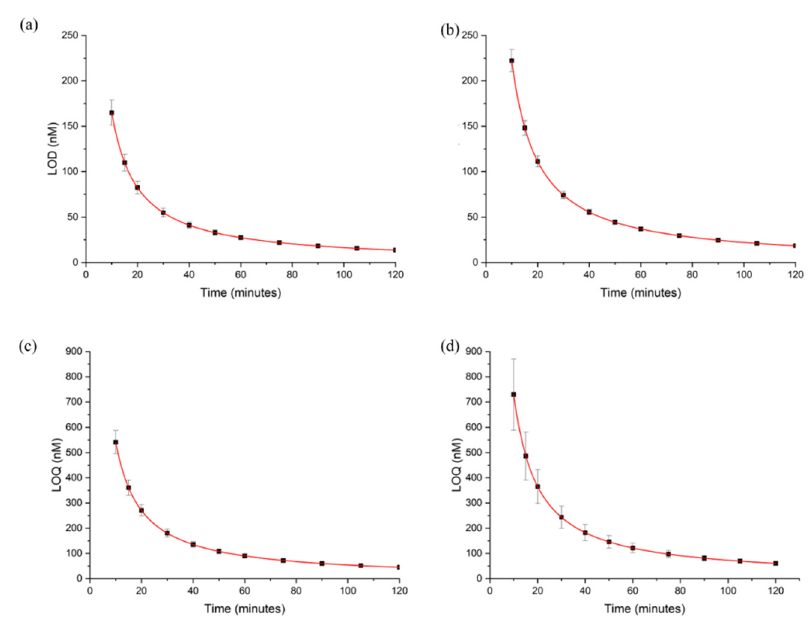
Figure 10. The limit of detection (LOD) for β -glucuronidase sensing CS/PEO NFs ( a ) and CS/PEO HG’s ( b ) and the limit of quantification (LOQ) for CS/PEO NFs ( c ) and CS/PEO HG’s ( d ). Similarly, the LOD of β -glucuronidase for PUAA micro-cuboid structured films was determined. The initial apparent rates of reaction were plotted against the initial concentrations of the enzyme. The initial apparent rate of reaction was found to be 4.5 ± 2.9 min − 1 nM − 1 and depended linearly on the initial enzyme concentration. The rate constant was obtained from the slope in Figure 11a and observation time was chosen arbitrarily.